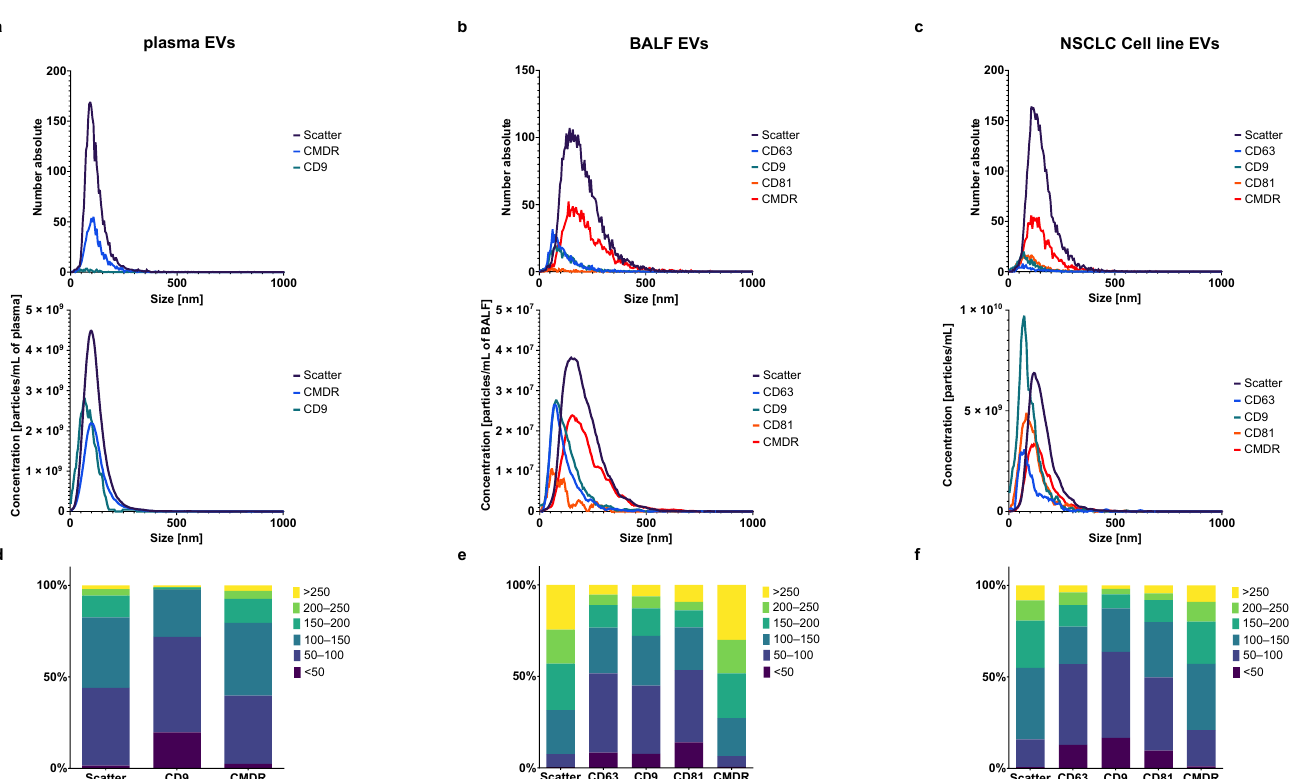
Figure 5. Size distributions from FL-NTA of particles in scatter and fluorescent mode (488, 640 nm) after immunolabeling of EVs against EV specific markers CD63, CD81, and CD9 and membrane marker CMDR. ( a – c ) Representative distributions measured in scatter and fluorescence mode of EVs from plasma ( a ), oBALF ( b ), and NSCLC cell line ( c ). The upper graphs present absolute numbers of particles measured by NTA, and the lower present the concentration of particles per one mL of plasma/BALF/NSCLC cell line EVs. The concentration of particles per one mL of each biological fluid is calculated by Particle Matrix software as Concentration = Number/(Area × depth). The component “Area x depth” differs between measures and is constant in the single measurement. Its value depends on outliers during each measurement. This “measured volume” effect leads to a different curve profile between the number absolute graphs and concentration graphs. ( d – f ) Concentration of particles—fraction of all particles [%] in six size fractions (<50 nm, 50–100 nm, 100–150 nm, 150–200 nm, 200–250 nm, >250 nm) for plasma ( d ), BALF ( e ) and cell line EVs ( f ). For all exact percent values, see